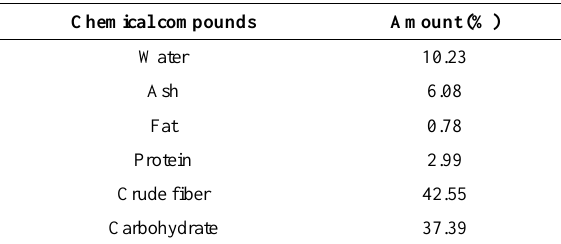
Table 1 . The moisture content and chemical composition of whole OPT flour